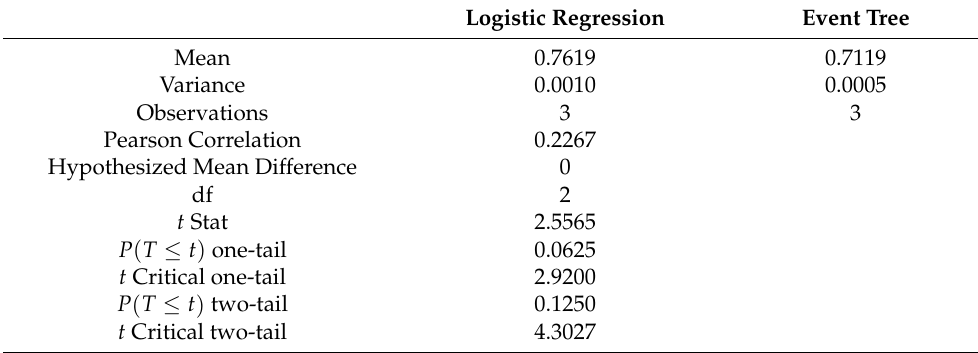
Table 2. Summary statistics for comparing the performance between the regression and the event tree.